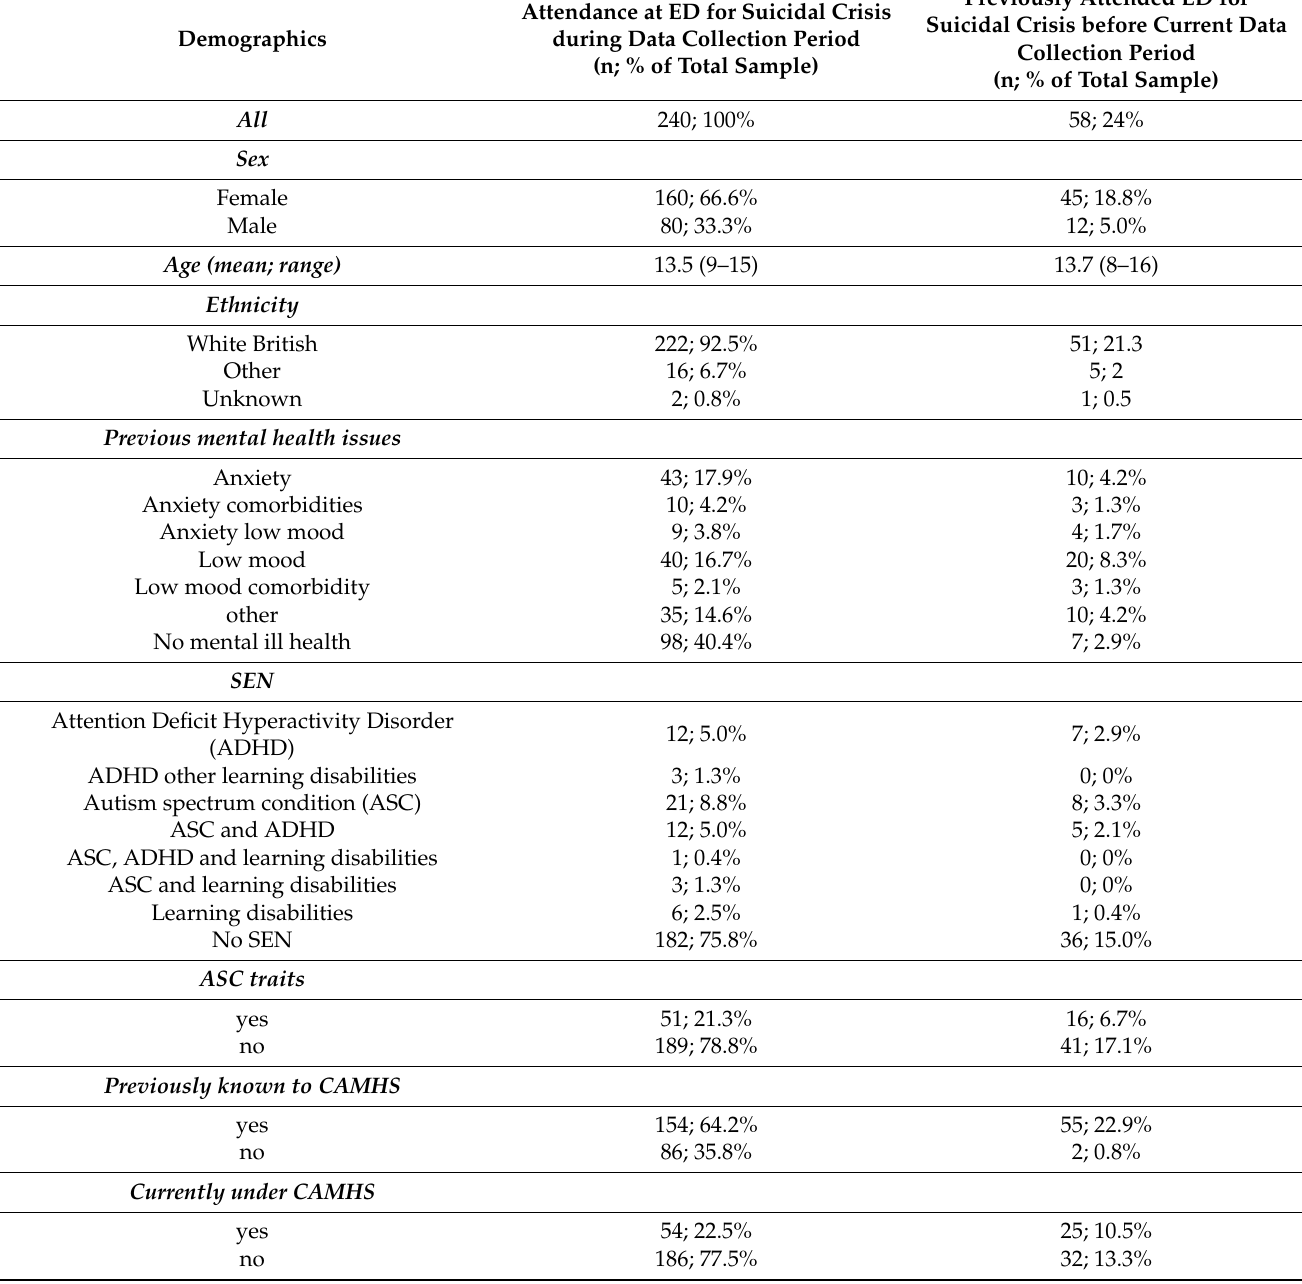
Table 1. Demographic details of patients attending Emergency Department (ED) in suicidal